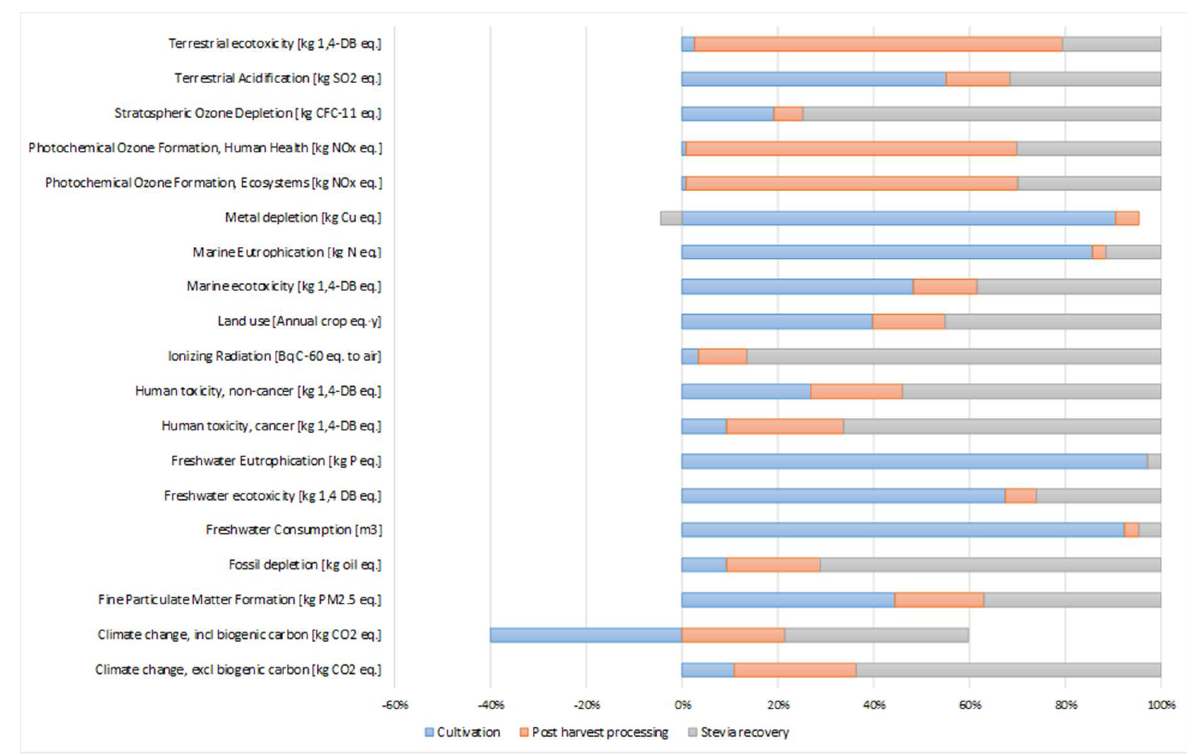
Figure 2. Contribution of the individual processes to impact categories—System A.